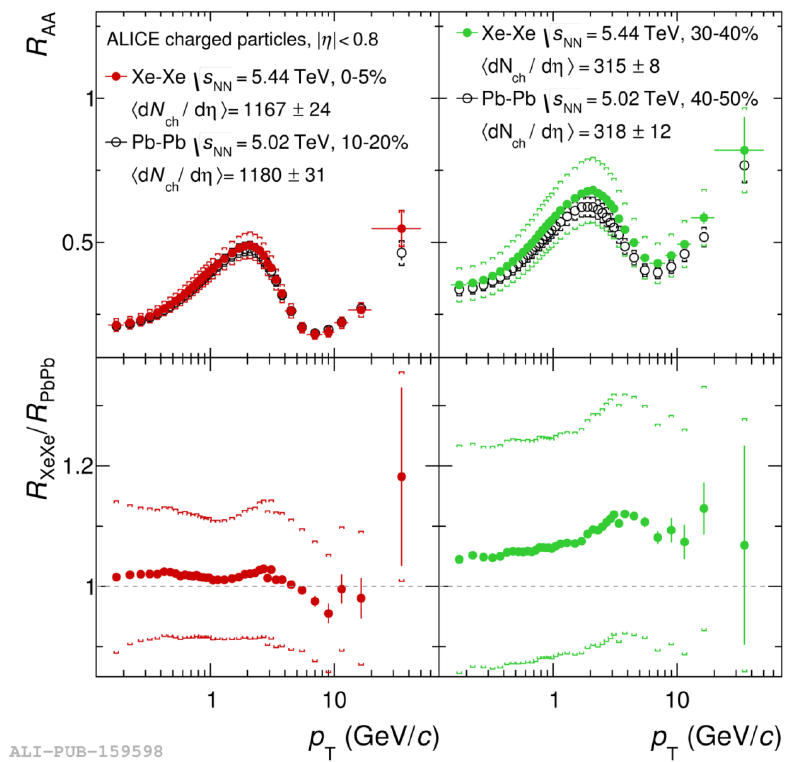
Figure 11. Comparison of nuclear modification factors in Xe–Xe collisions (filled circles) and Pb–Pb collisions (open circles) for similar ranges in d N ch /d η . Figure taken from